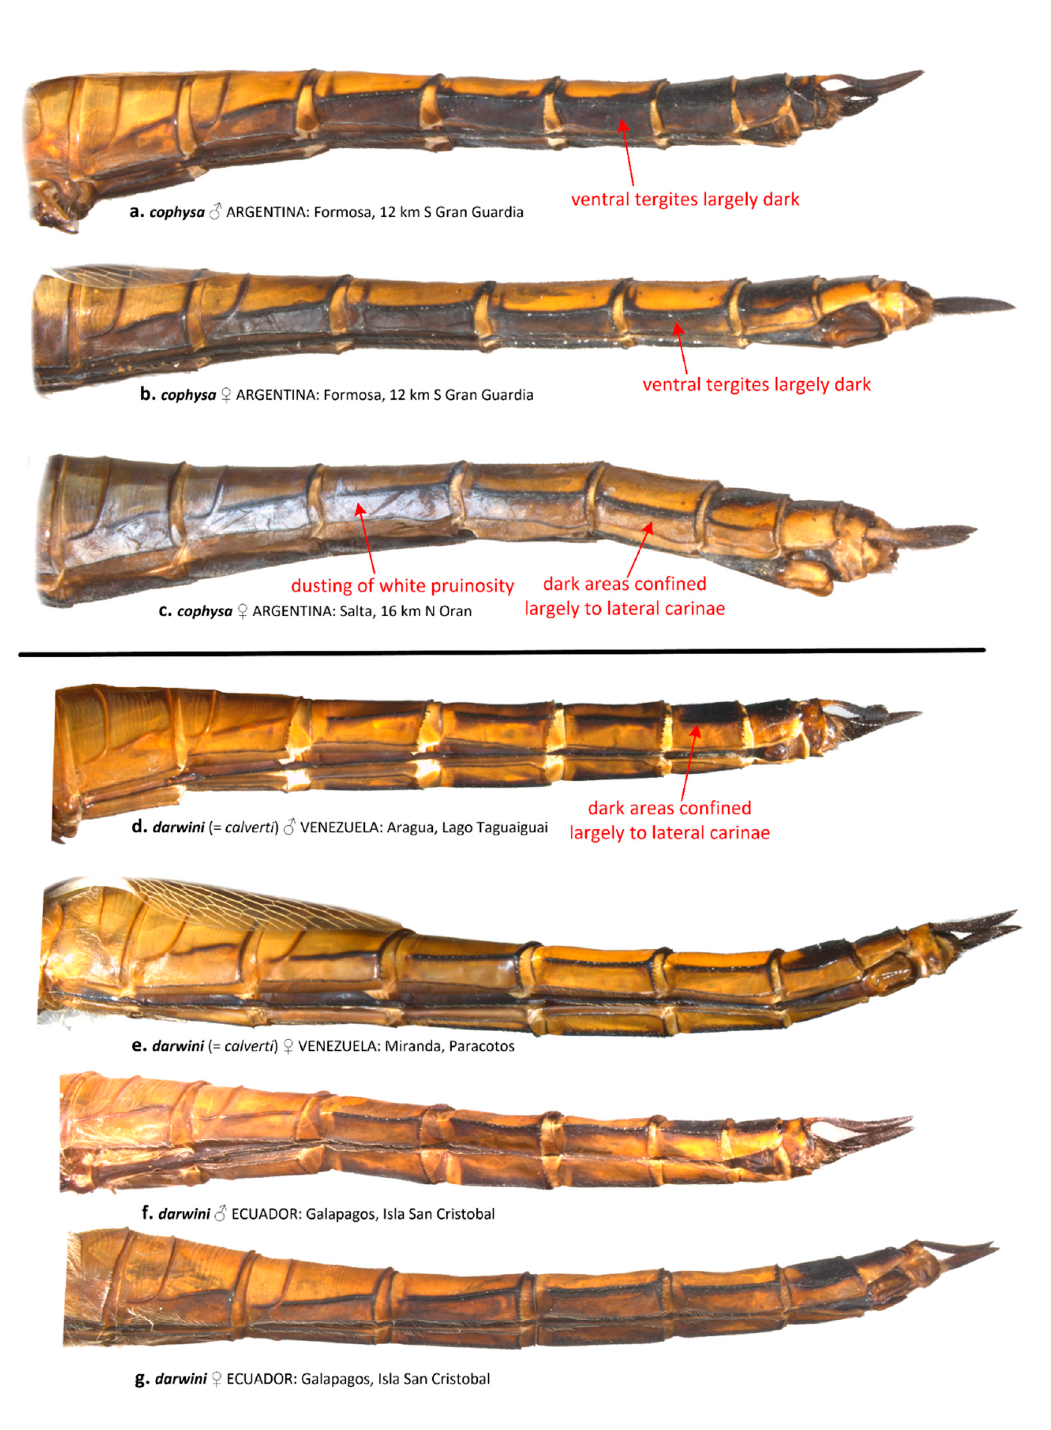
Figure 6. Left ventrolateral view of the abdomen of T. cophysa ( a – c ) and T. darwini (senior synonym of T. calverti , stat. rev.) ( d – g